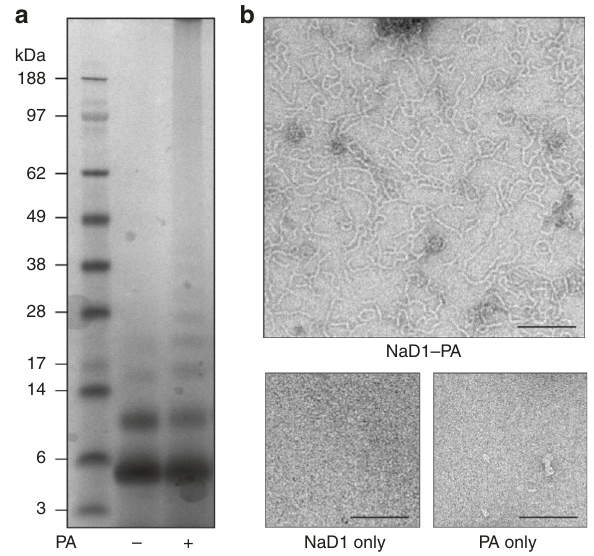
Fig. 1 NaD1 forms oligomers with PA. a , b The ability of wild-type NaD1 to form multimeric complexes in the presence of PA as determined by ( a ) protein – protein crosslinking with BS 3 and visualized by SDS-PAGE, and by ( b ) transmission electron microscopy. Scale bars represent 200